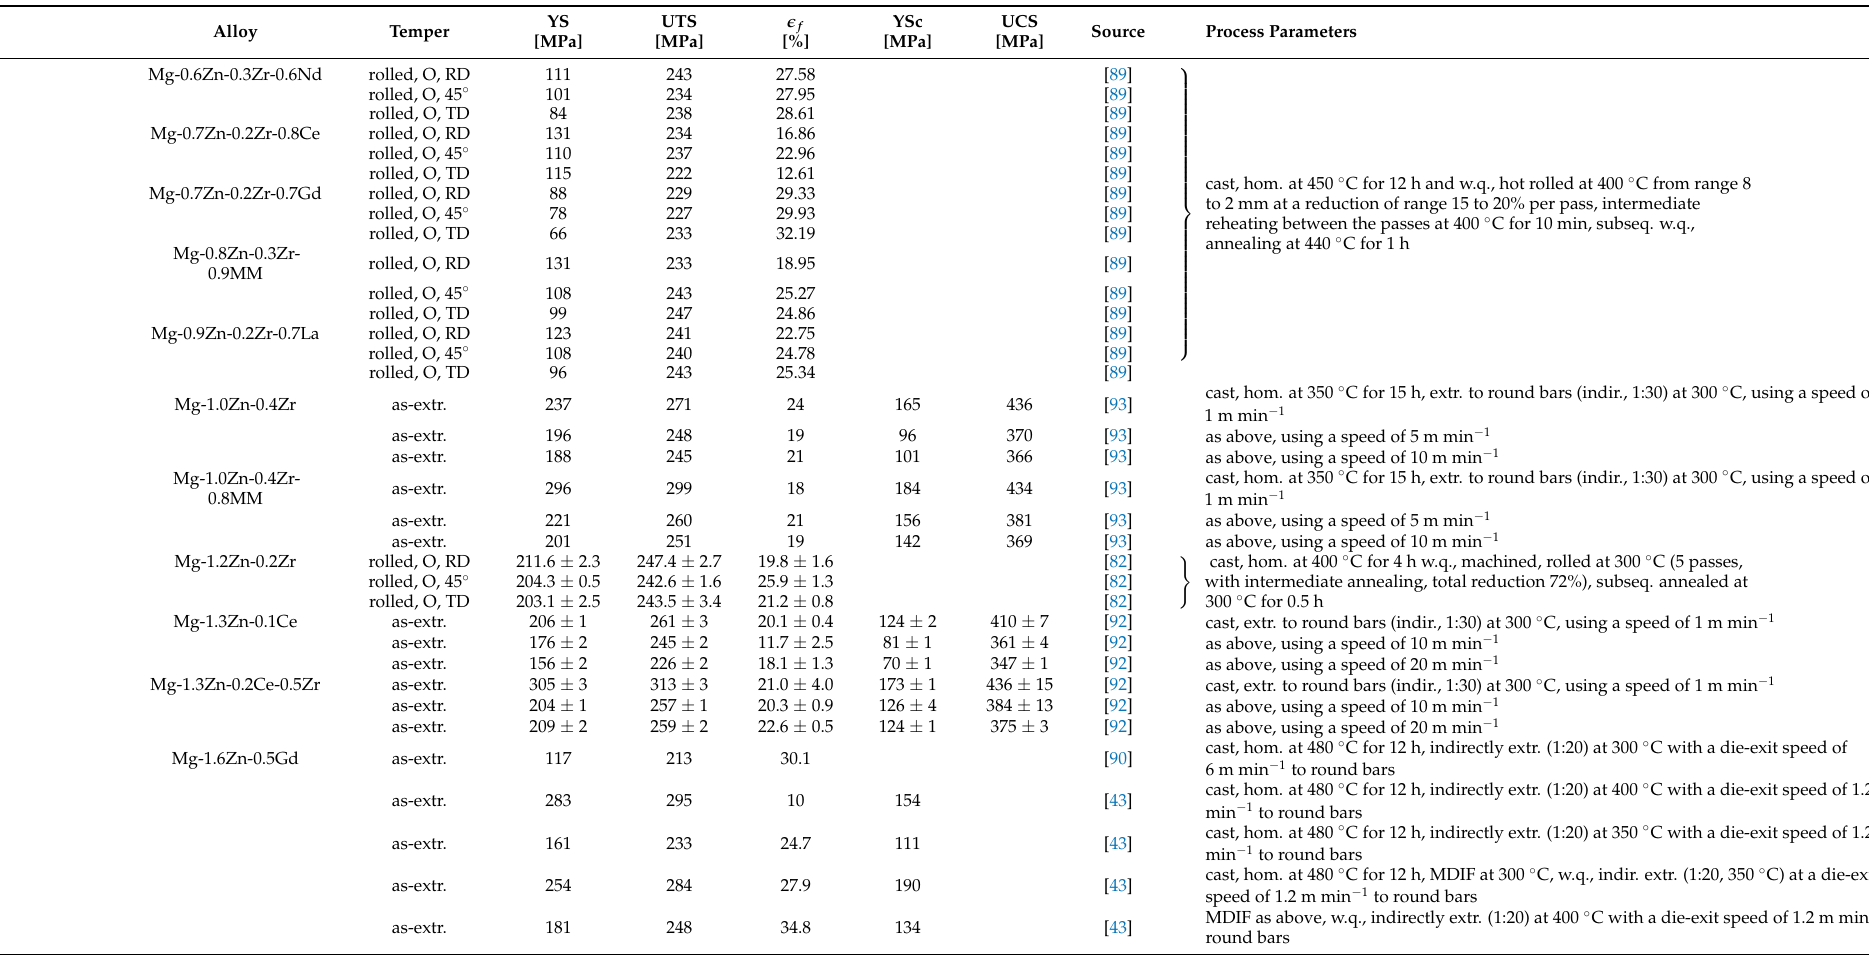
Alloy Mg-0.6Zn-0.3Zr-0.6Nd rolled, O, RD [89]   hrolled,